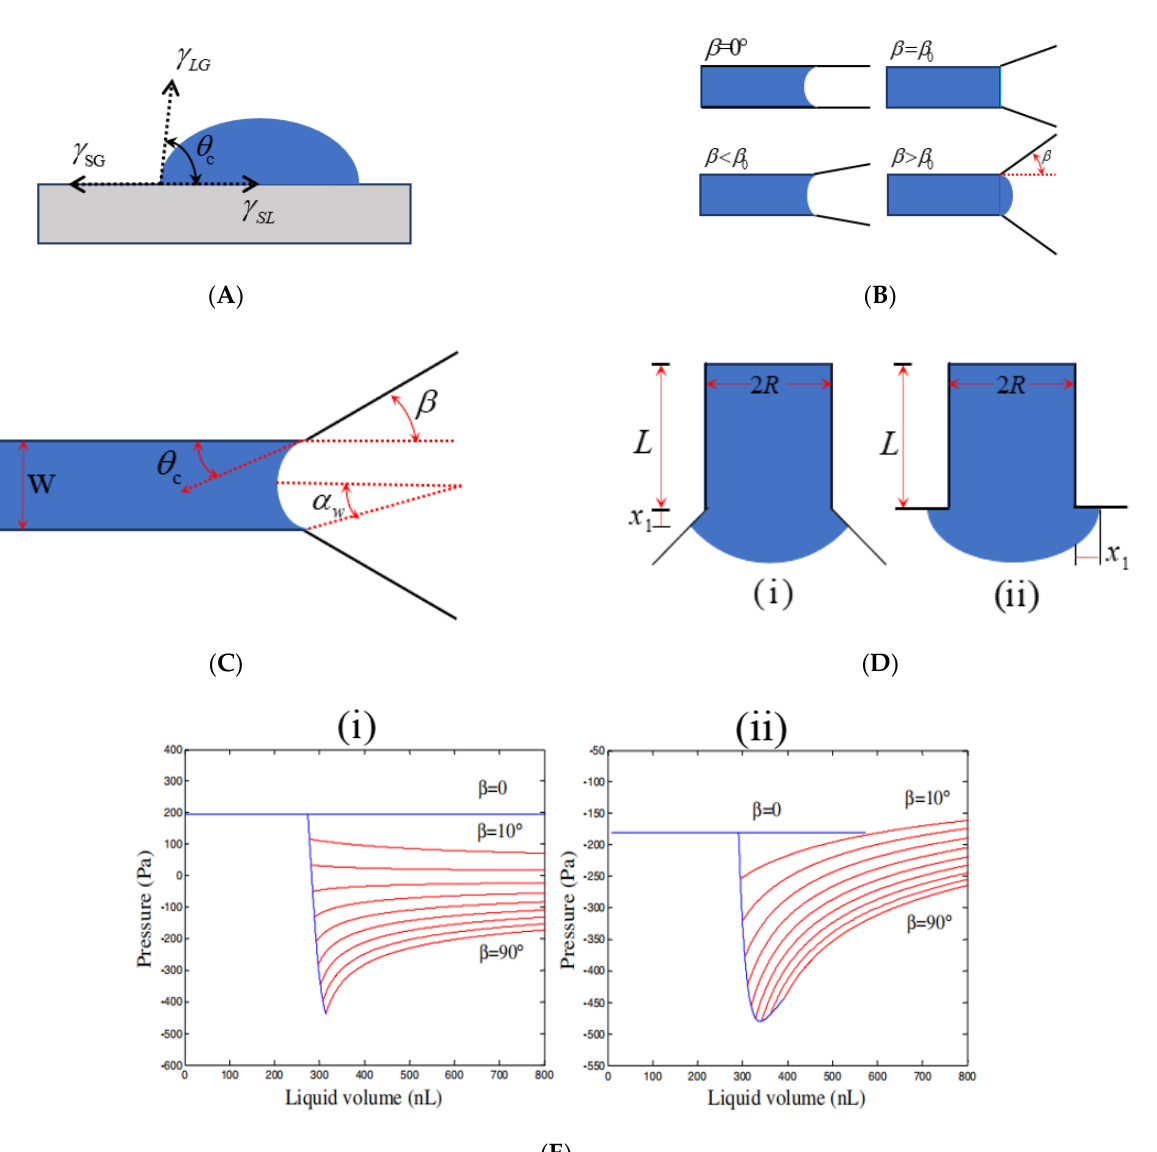
Figure 1. CPCV parameters and their relationships. ( A ) Definition of contact angle. ( B ) The relationship between the angle of triangle expansion β and the liquid level meniscus. ( C ) The common geometrical parameters in CPCV boundary pressure model are given. ( D ) Meniscus of axisymmetric channel in expansion regime bursting into divergent section, where advancement of liquid is described mainly by wetted length x 1 for (i) β < 90 ◦ and (ii) β = 90 ◦ . ( E ) Variation in liquid pressure with liquid volume for hydrophilic and hydrophobic channels of R = 0.3 mm with expansion angles ranging from β = 0 to 90 ◦ , ( i ) hydrophilic channels interfacial properties γ = 0.072 N/m and θ c = 66 ◦ ; ( ii ) hydrophobic channels interfacial properties γ = 0.072 N/m and θ c = 112 ◦ . Reprinted with permission from [56]. Copyright (2008) The Japan Society of Applied Physics.